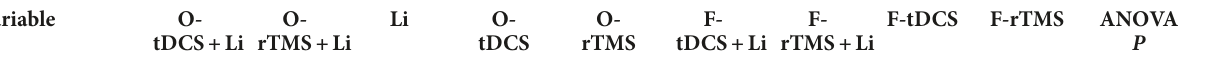
TABLE 1 Effects of 24-week treatments on cognitive impairment.